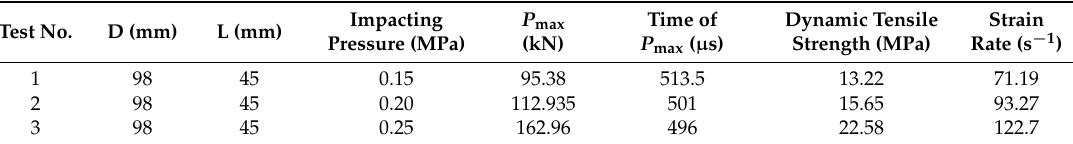
Table 3. Results of numerical tests at different strain